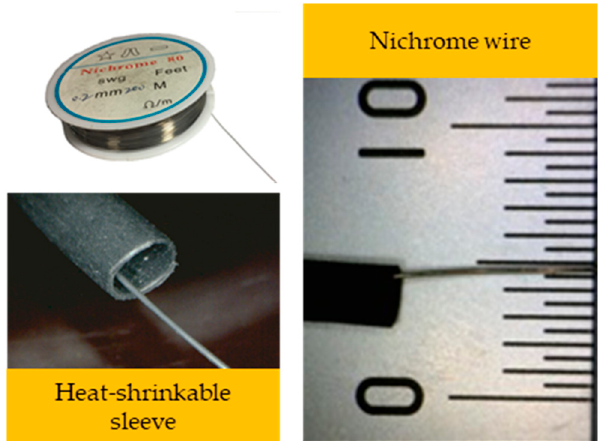
Figure 5. Nichrome wire of the string-type strain gauge.